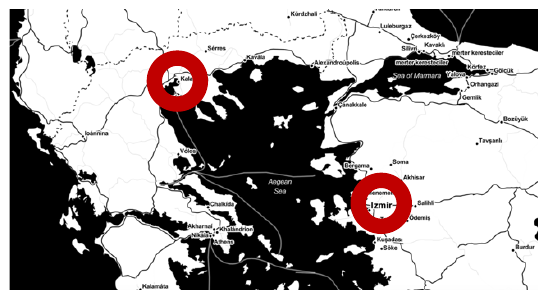
Figure – 1 Izmir and Thessaloniki in Aegean